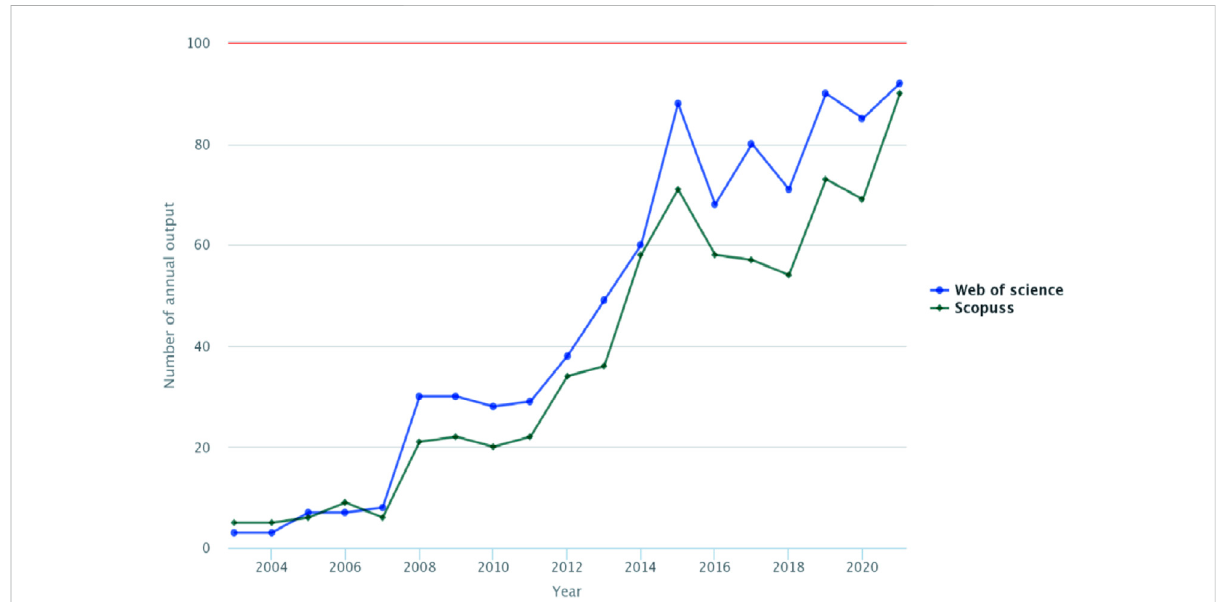
FIGURE 2 AnnualpublicationsofSCstherapyforIDDfrom2003to2021.Thetrendscanbesplitintothreephases.First,2003 – 2007,theinitiationphase,is characterised by a slow rise; second, the rapid development phase, 2007 – 2015, is characterised by a continuous rise; third, the stable development phase, 2015 – 2021, is characterised by a circular rise. 2021 is also by far the most published year.